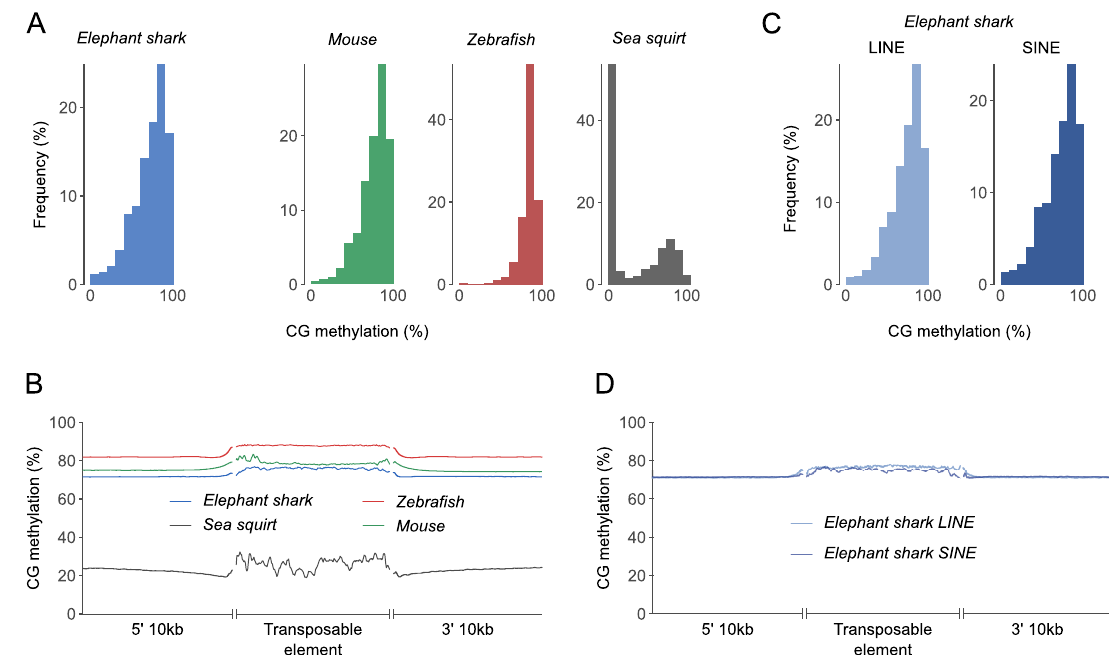
Figure 4. Methylation patterns at transposable elements. A: Distribution of methylation at transposable elements. Mean methylation values are divided into 10 bins. B: Mean CG methylation across transposable elements and 10kb flanking regions. Quantification was performed at the level of individual CG dinucleotides. Flanking regions were smoothed by averaging 100 neighbours. C: Distribution of methylation at long interspersed nuclear elements (LINEs) and short interspersed nuclear elements (SINEs) in the elephant shark genome. Mean methylation values are divided into 10 bins. D: Methylation at long interspersed nuclear elements (LINEs) and short interspersed nuclear elements (SINEs) in the elephant shark genome, plotted as in ( B